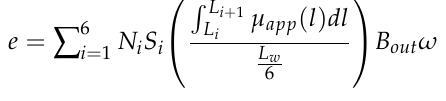
Figure 7. 2D axisymmetric GAFDEM of the winding and magnetic core. 3.2. Experimental Results The experiment consists of two parts: laboratory and fi eld experiments. For the laboratory experiment, the sensitivities of core coil and traditional air coil are compared inside an electromagnetically shielding laboratory. For the fi eld experiment, we obtain the signals received by di ff erent coils and calculate di ff erent detection results according to the signals. 3.2.1. Laboratory Experiment After completing the design of two options for increasing sensitivity, we conduct a sensitivity test and compare it with the air coil. The results are shown in Table 1. An AC current source is used to provide excitation for the Helmhol tz coils. This source produces